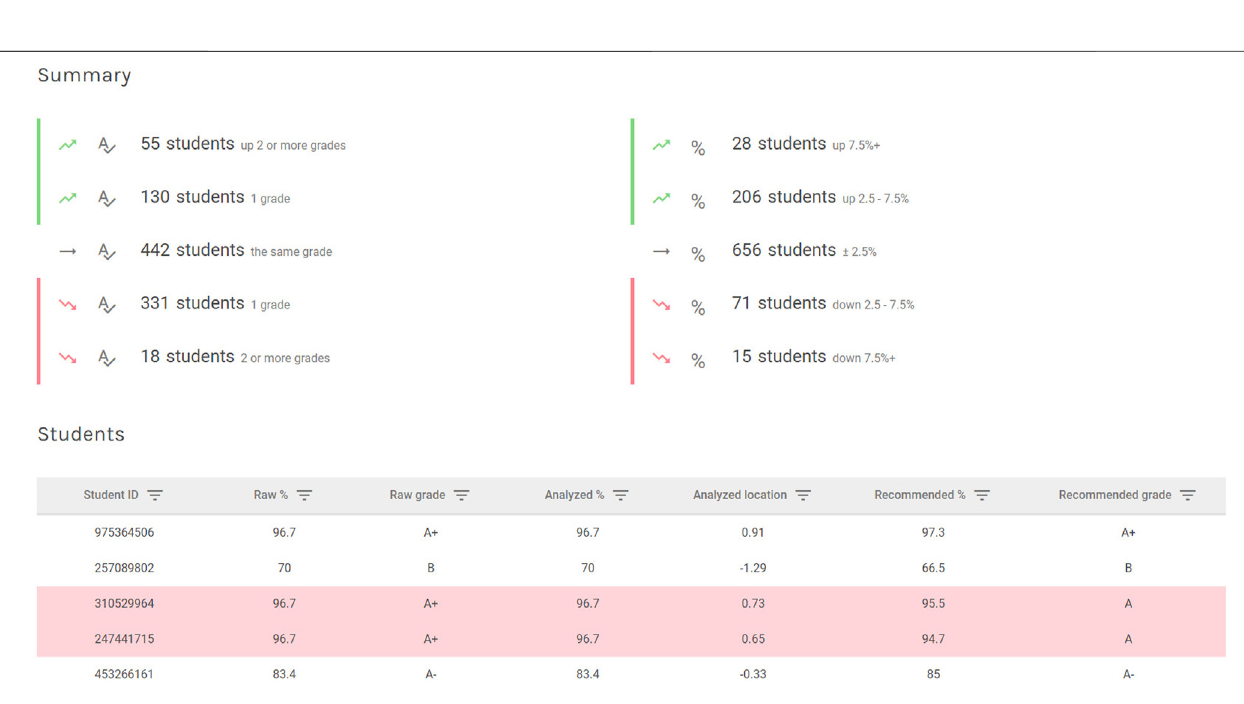
Frontiers in Education |